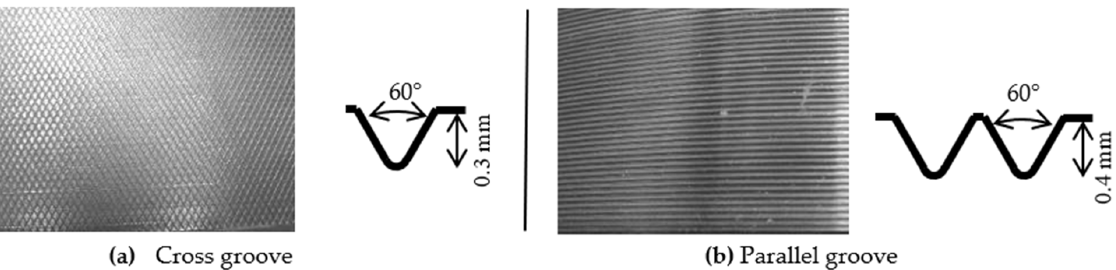
Figure 6. Orientation of the roll surface.